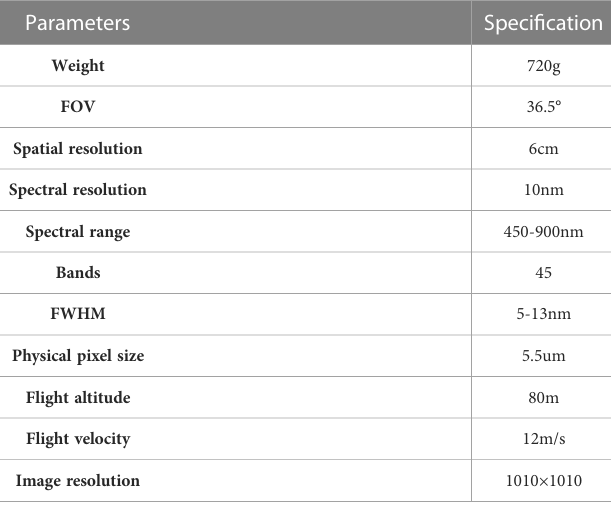
TABLE 1 Primary parameters of unmanned aerial vehicle hyperspectral imaging system.